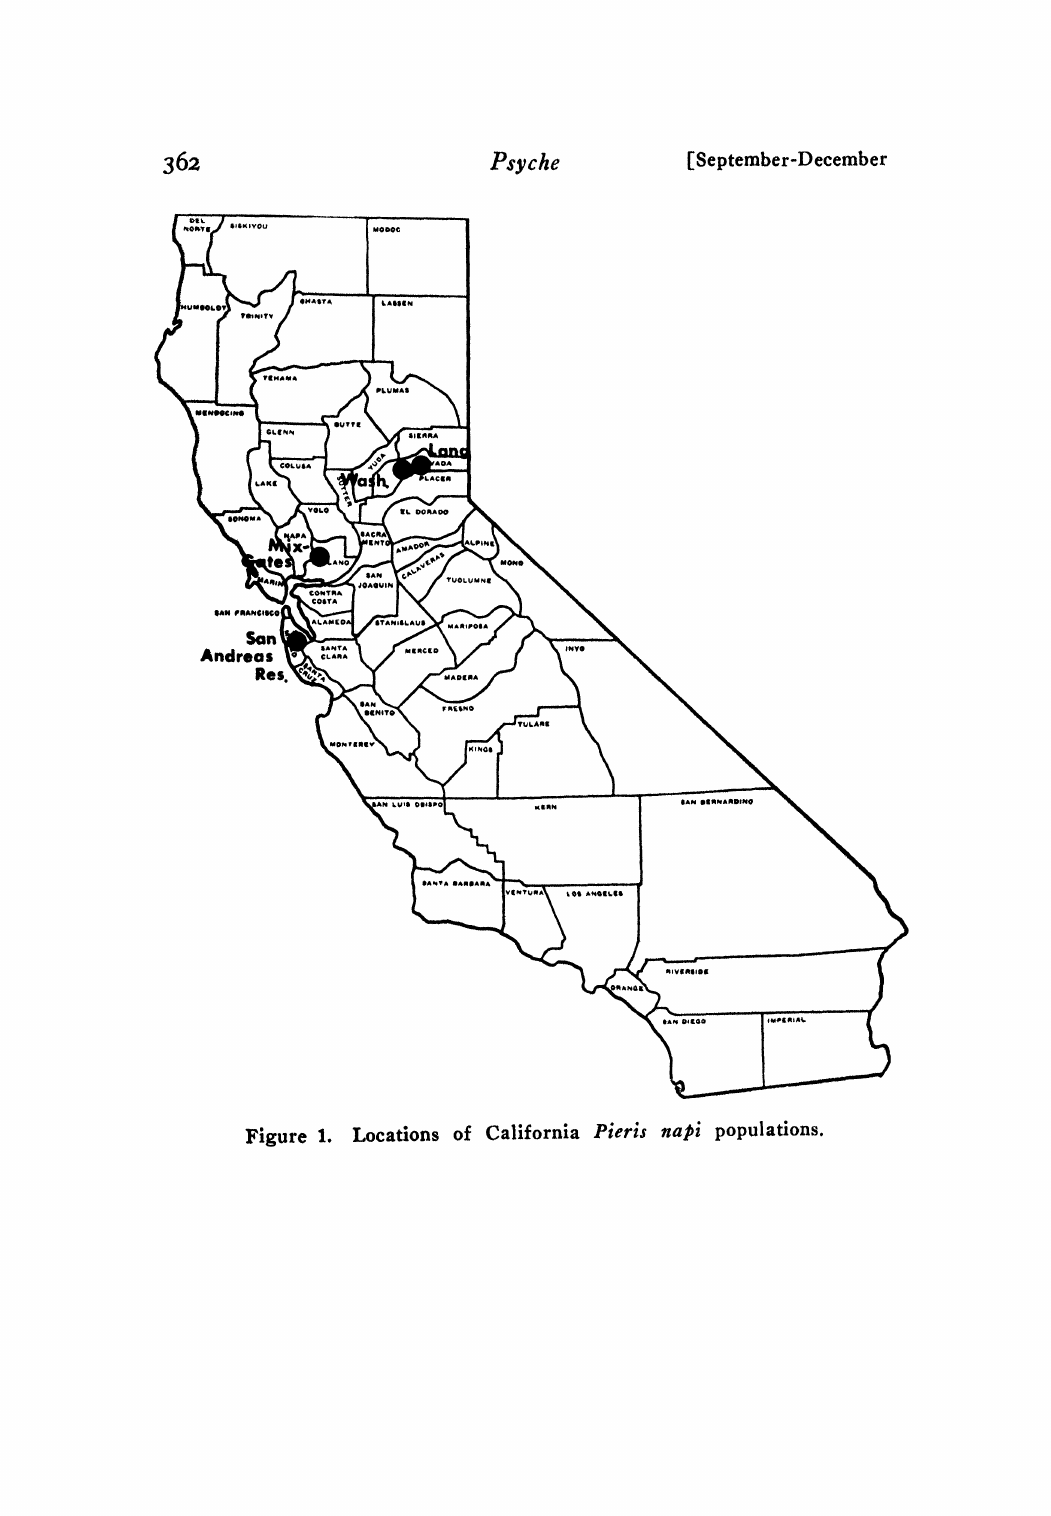
Figure 1. Locations of California Pieris napi